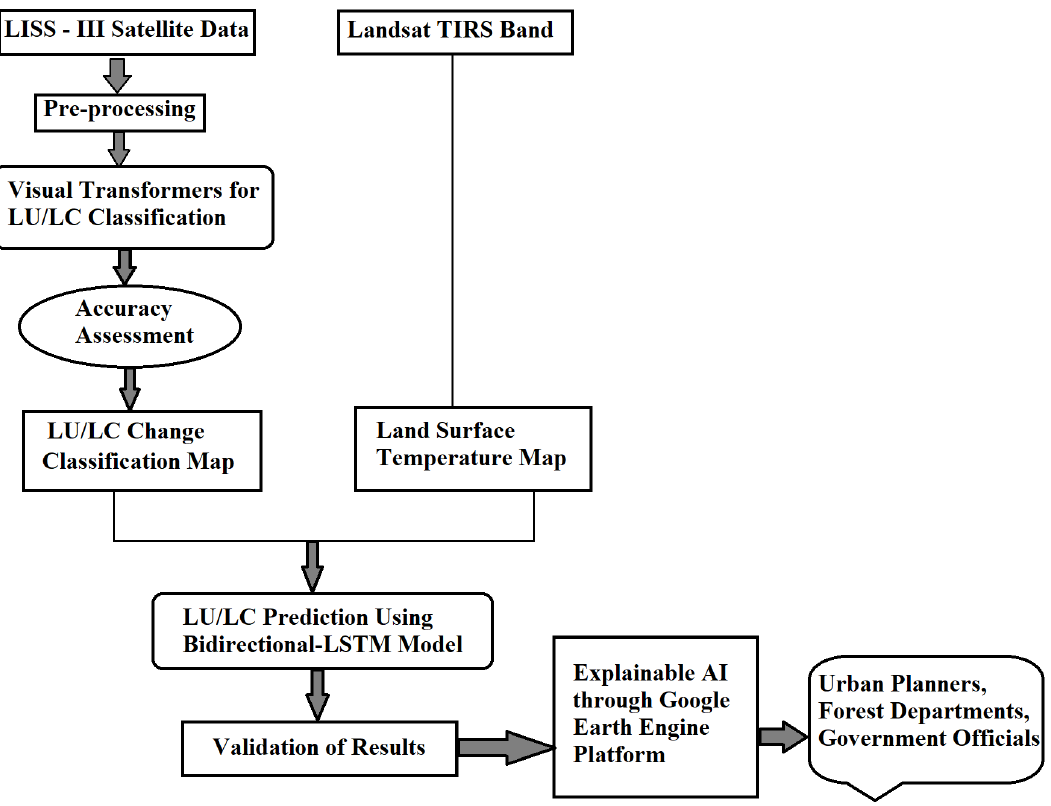
Figure 16. Proposed flow of LU/LC prediction using Vision Transformer–based Bi-LSTM model.